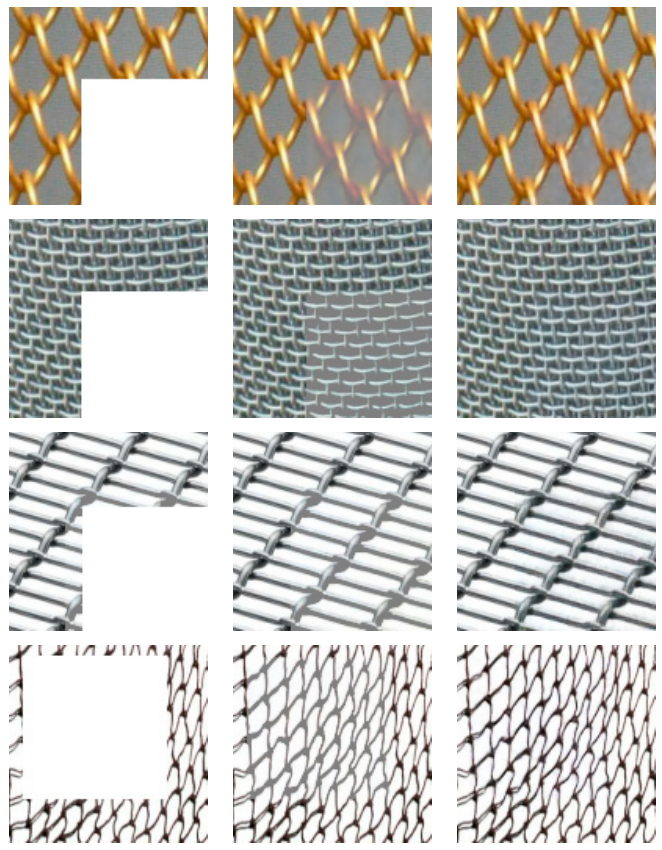
Figure 9. The results comparison of Iizuka’s method and ours with barbed wire images.